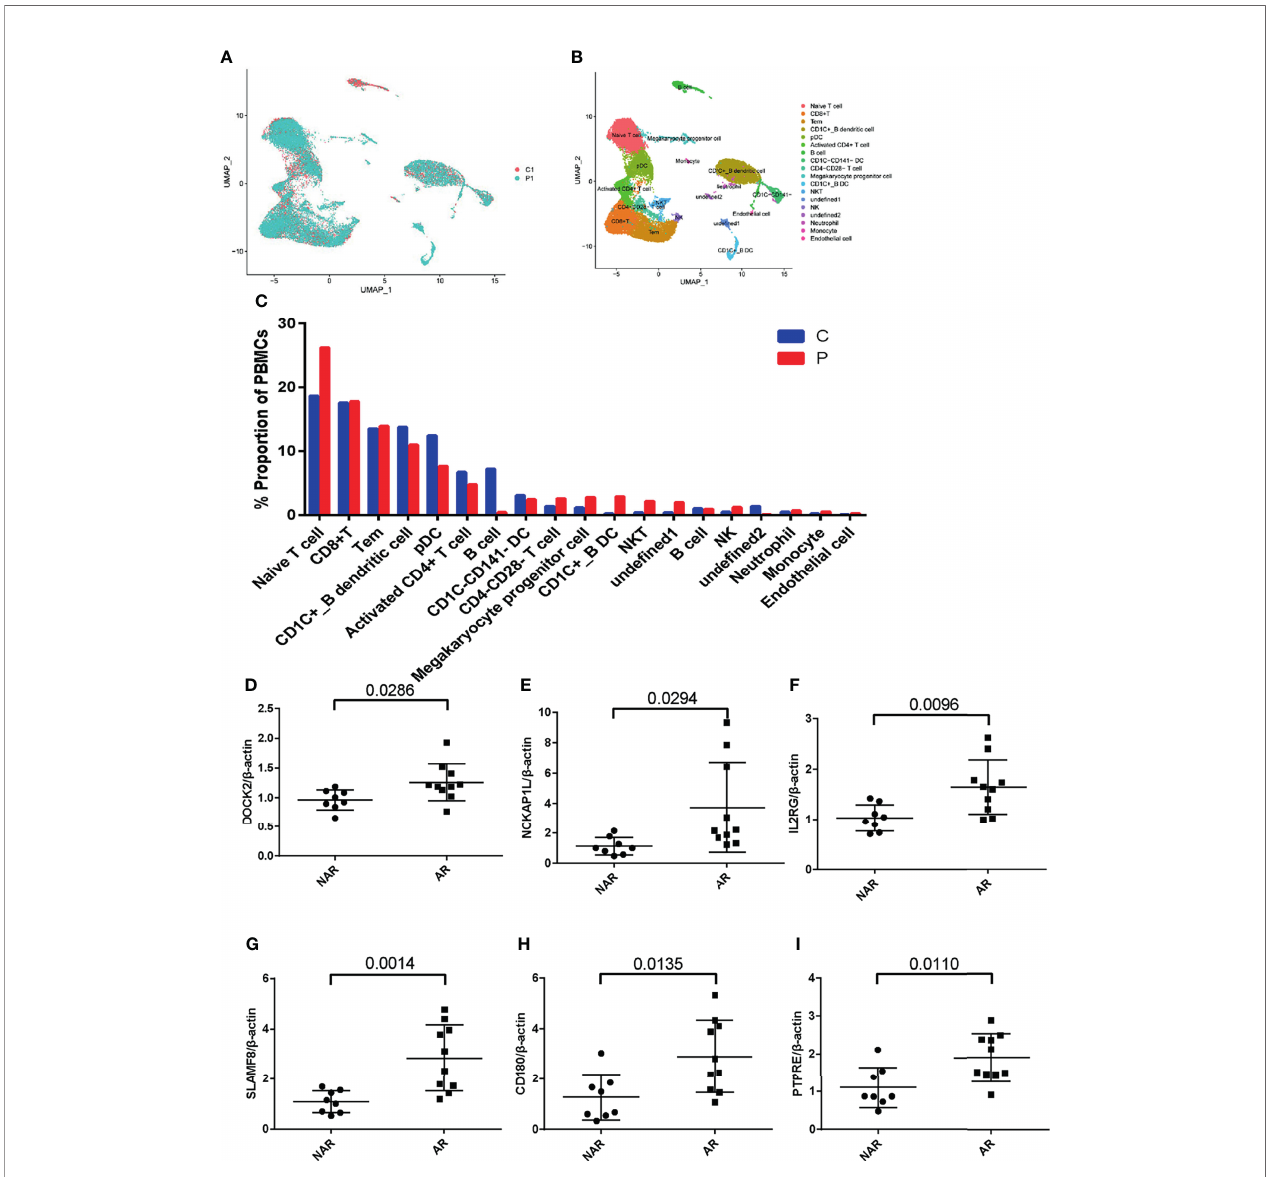
FIGURE 5 | scRNA-seq in patient PBMCs of acute rejection post renal transplant and qRT-PCR validation. (A) Uniform manifold approximation and projection (UMAP) of 26,192 cells, split between P1 and C1. (B) UMAP plot of 19 cell clusters identi fi ed based on the expression of highly variable genes. (C) Single-cell RNA sequencing revealed a higher percentage of native T, CD1C+_B DC, NKT, NK, and monocytes in P1 compared with C1. Relative mRNA expression of DOCK2 (D) , NCKAP1L (E) , IL2RG (F) , SLAMF8 (G) , CD180 (H) , and PTPRE (I) were measured in peripheral blood mononuclear cells (PBMCs)of 8 NAR and 10 AR patients. Data shown are mean ± SD by an unpaired t-test; P1, patient of acute rejection post renal transplant; C1, control patient of stable kidney function post renal transplant; NAR, non-acute rejection; AR, acute